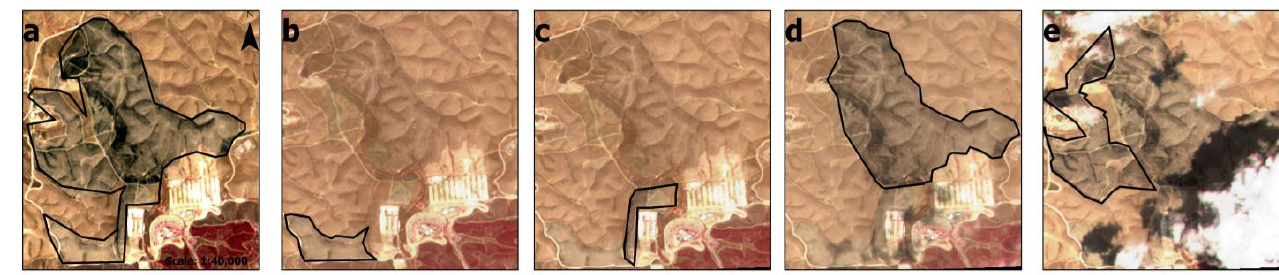
Figure A1. Flowchart of the creation process of Israel’s national wildfires database.